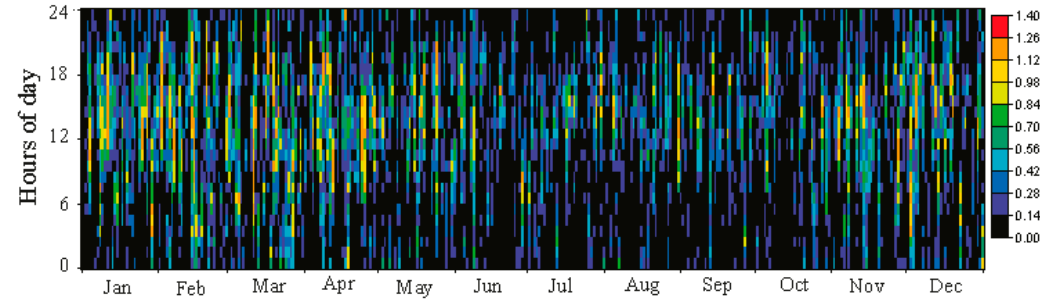
Figure 14. Monthly statistics of the WTG output power.